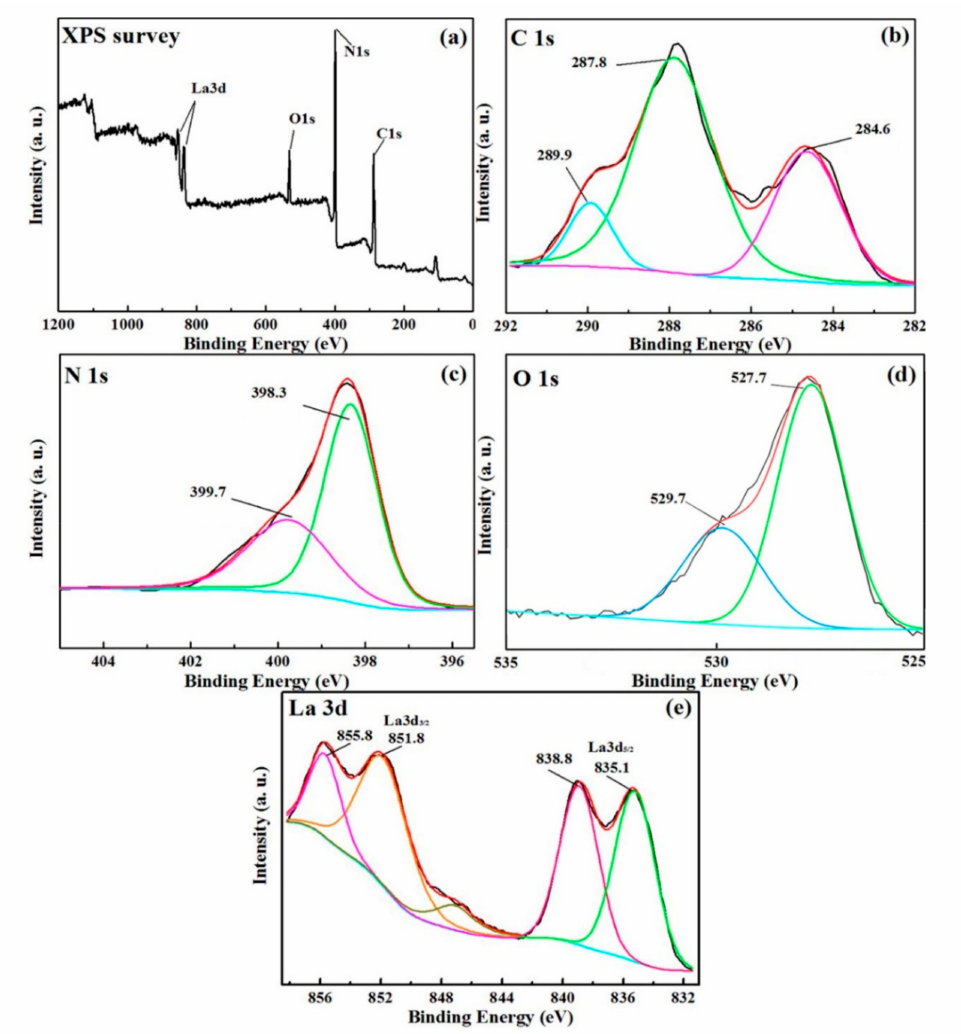
Figure 4. XPS survey pattern of 10LaO/CN ( a ); the high-resolution XPS spectra of C 1s ( b ), N 1s ( c ), O 1s ( d ) and La 3d ( e